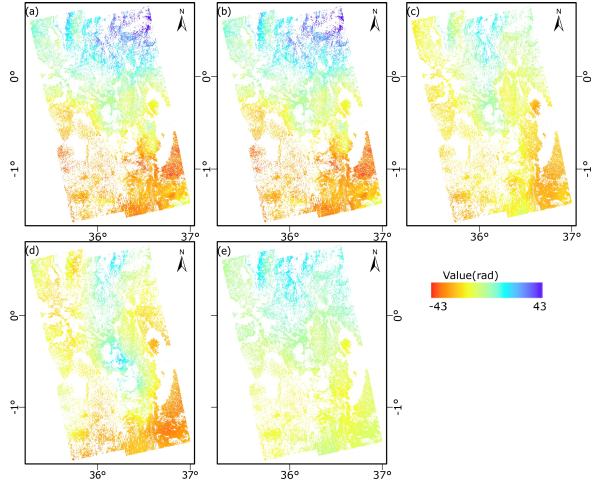
Figure 2. Estimates of tropospheric delay for three SAR acquisition dates, 2018-01-26, 2018-02-07, and 2018-02-19, based on equation 5. (a) displays the original interferogram-based estimates, while (b) depicts the SAR-based estimates, whereas (c), (d), and (e) display the tropospheric delay estimates from GACOS, ERA-5, and MERRA-2,